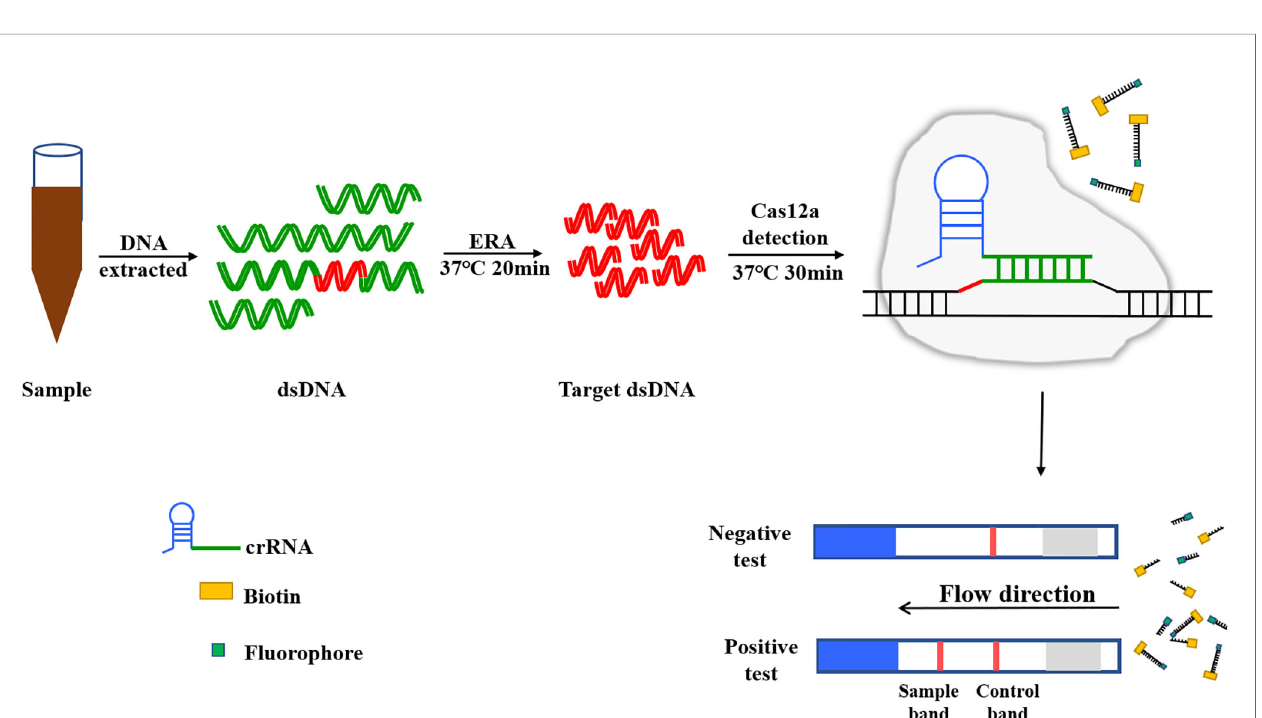
FIGURE 3 | CRISPR/Cas12a based lateral fl ow detection, experimental work fl ow.